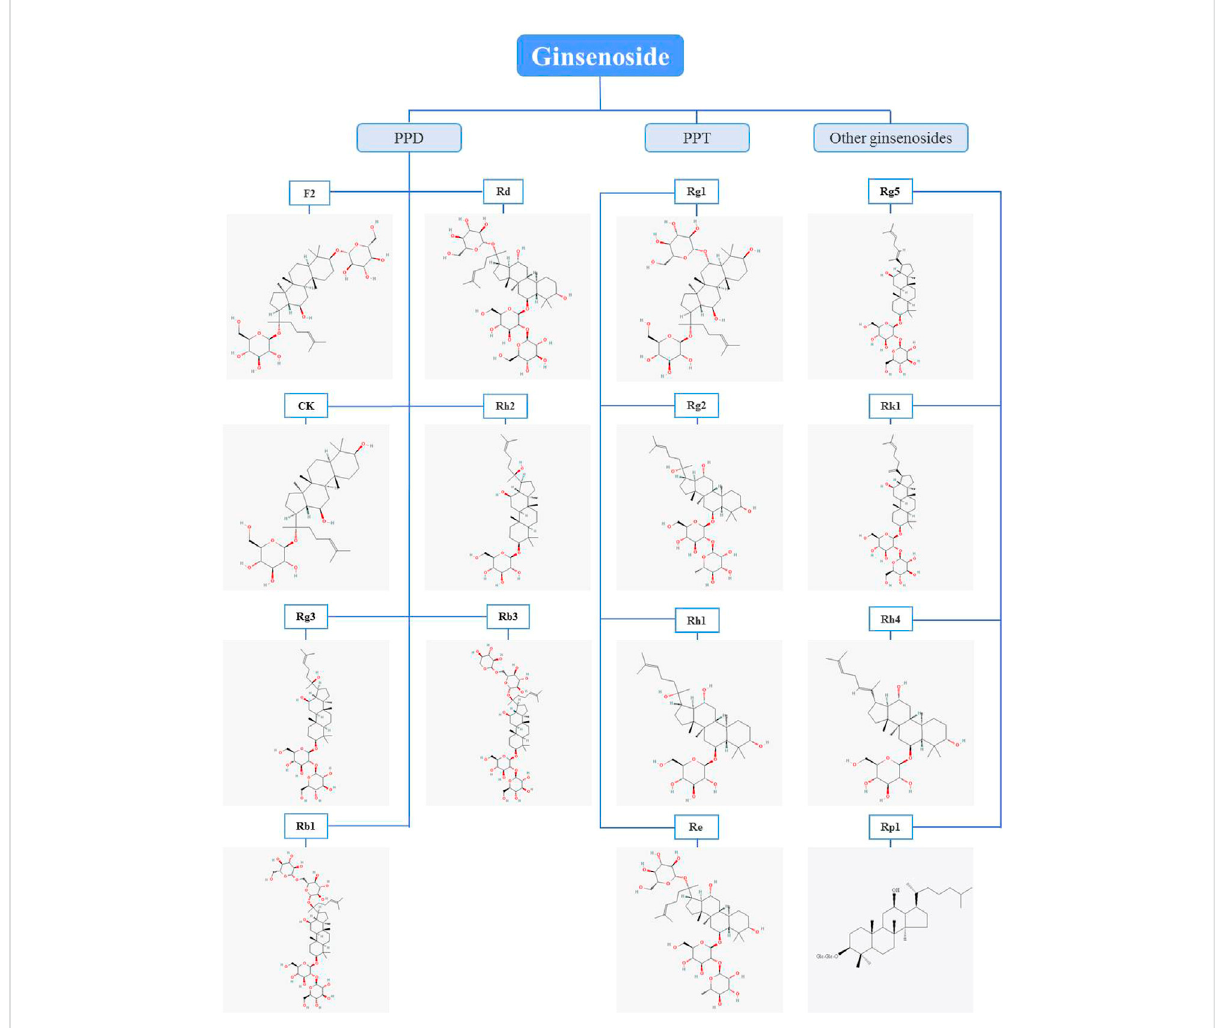
FIGURE 1 Chemical structures of ginsenosides with anti-breast cancer activity. Glc, glucose. The chemical structures of the ginsenosides included in this publication were obtained from pubchem, but ginsenoside Rp1 was drawn using the chemdraw